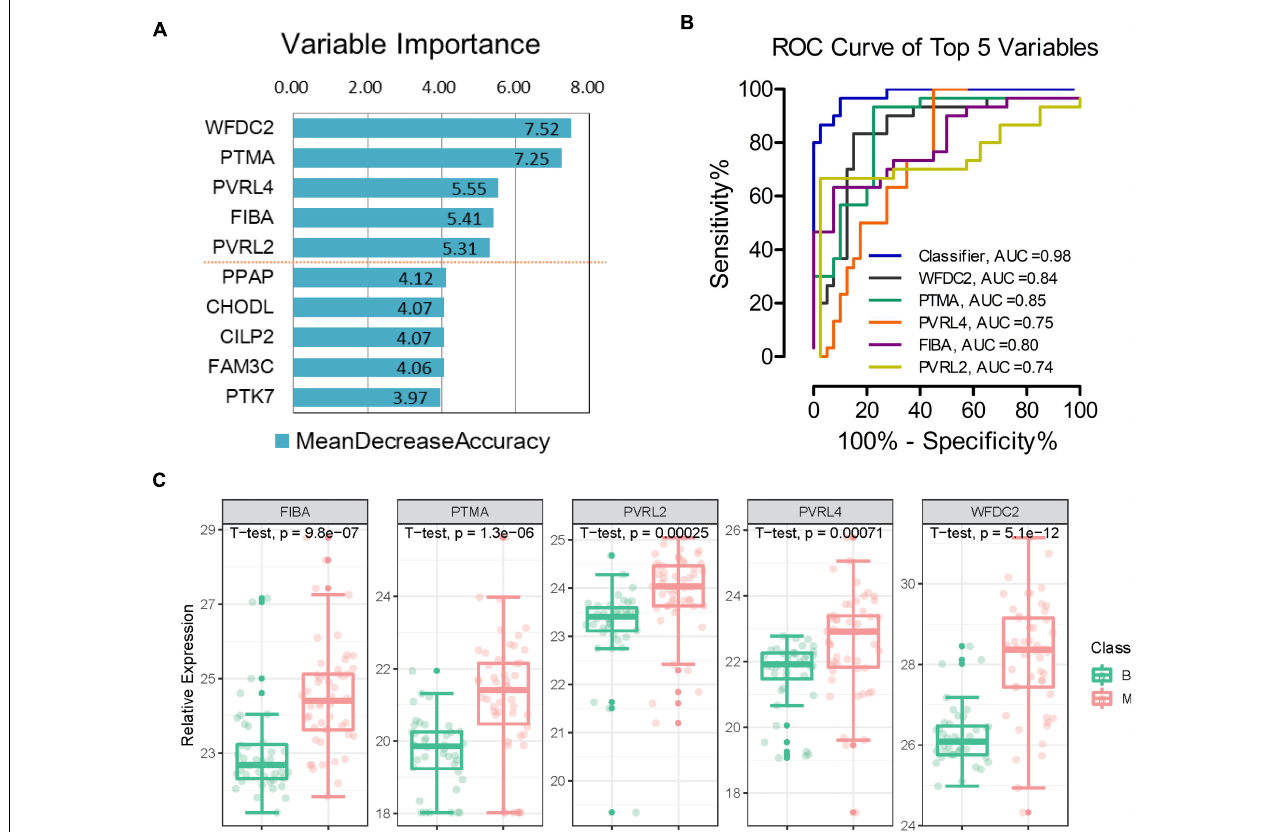
FIGURE 4 | Separation of benign and malignant patients by machine learning of proteomic features. (A) Top 5 proteins prioritized by random forest analysis ranked by the mean decrease in accuracy > 5. (B) Receiver operating characteristic (ROC) analysis of the classifier and each feature in the training dataset. (C) Expression levels of the five proteins; p -value was calculated in t -test medtod. *B, benign group; M, malignant